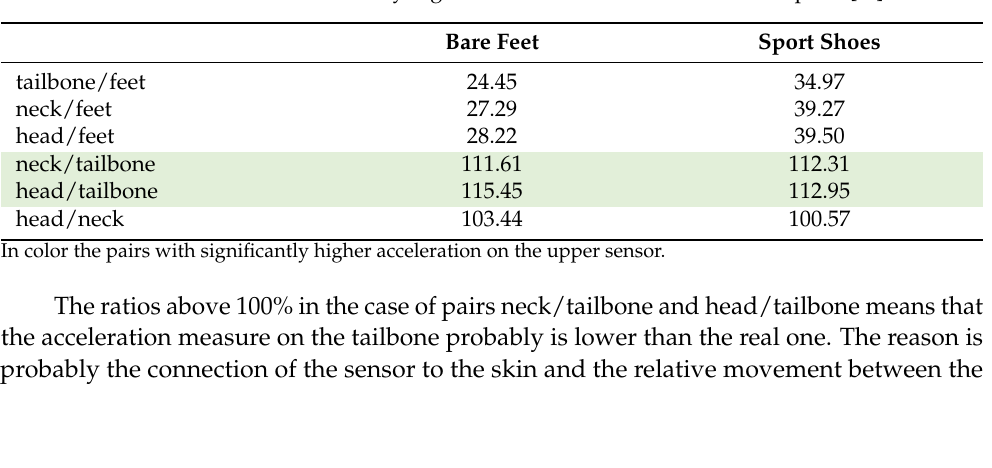
Table 5. Acceleration ratios measured by higher sensor to lower sensor: various pairs [%].